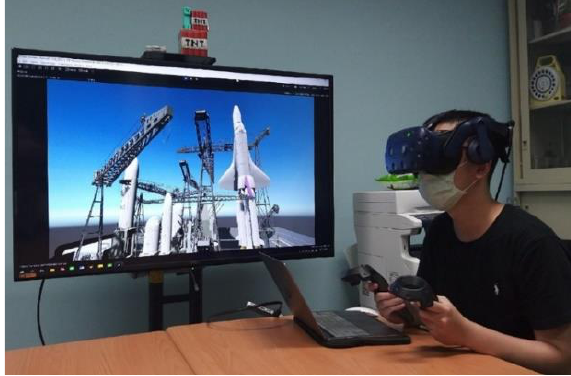
Figure 3. Wearing a head-mounted display to access the VR system.